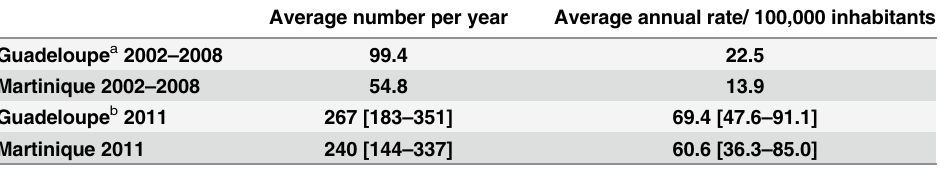
Table 2. Indicators of the health burden of leptospirosis between 2002 and 2008, and results of the 2011 incidence study in Guadeloupe and Martinique.